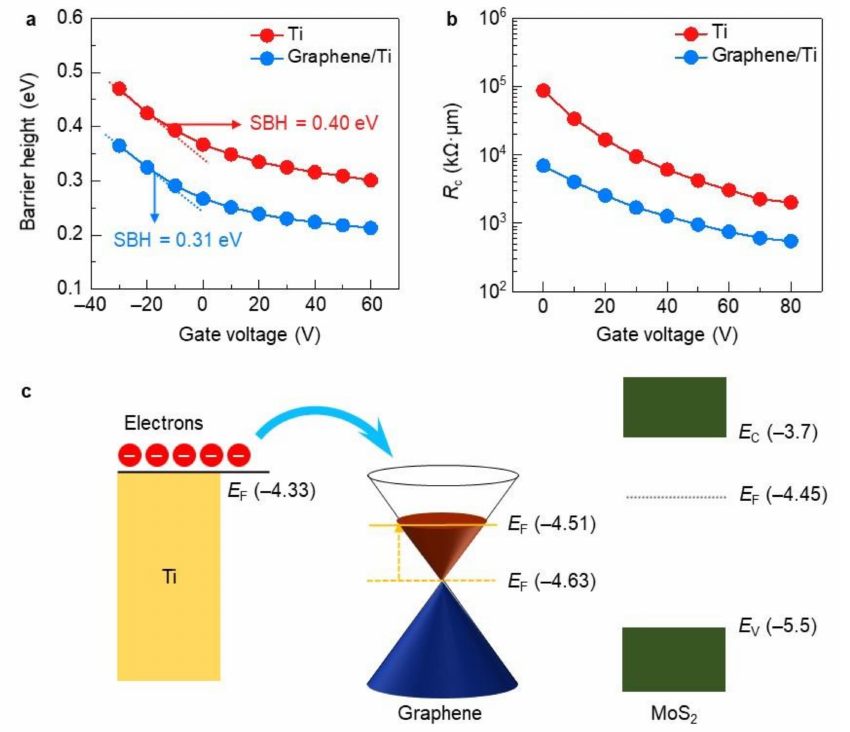
Figure 3. ( a ) Barrier height and ( b ) contact resistance ( R c ) of MoS 2 devices with Ti and graphene/Ti contacts. Barrier heights were obtained from the data in Figure S2. ( c ) Band alignment of MoS 2 monolayer contacted with graphene/Ti, where the Fermi levels ( E F ) of graphene and MoS 2 were extracted from the data in Figure